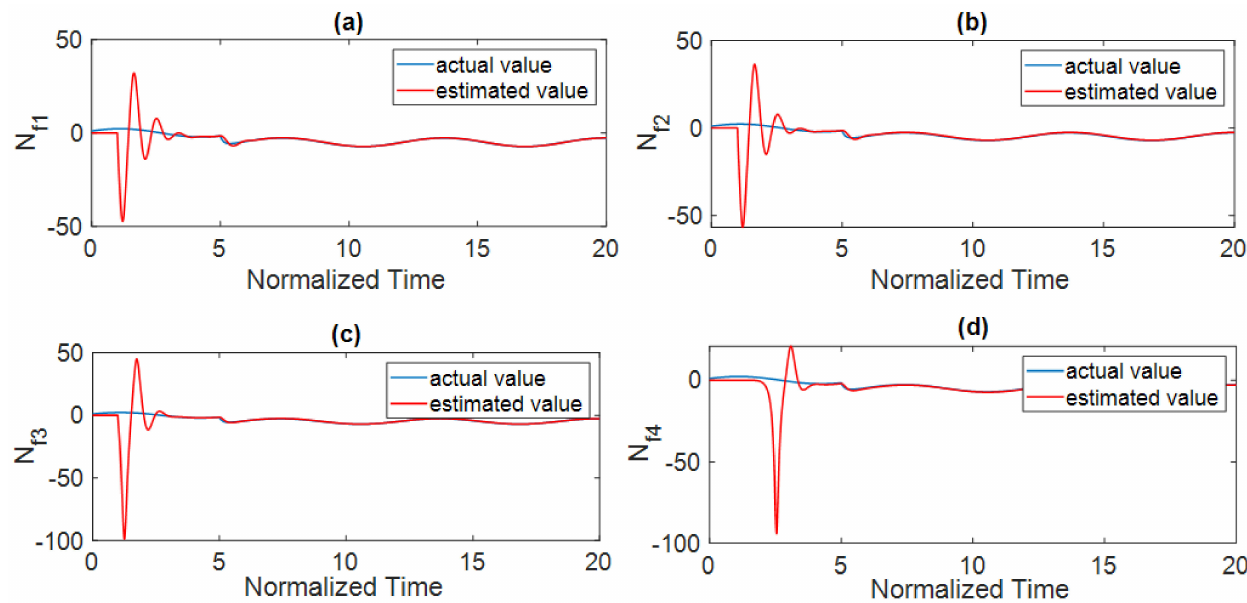
Figure 7. Estimated and actual values of faults and disturbances where there are bias faults. Disturbances and faults that are imposed on ( a ) x_1, ( b ) x_2, ( c ) x_3, ( d ) x_4.